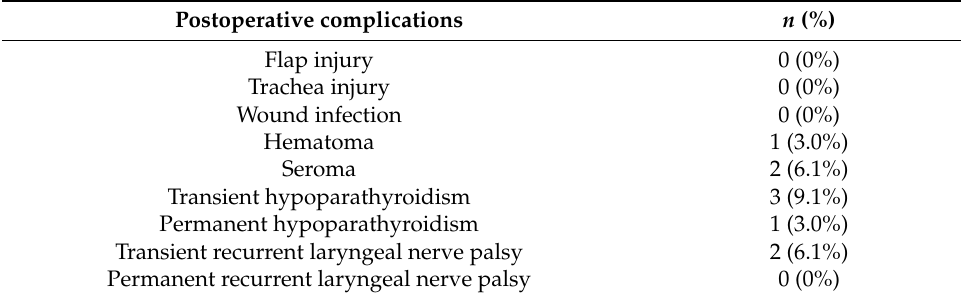
Table 4. Postoperative complications following BABA robotic completion